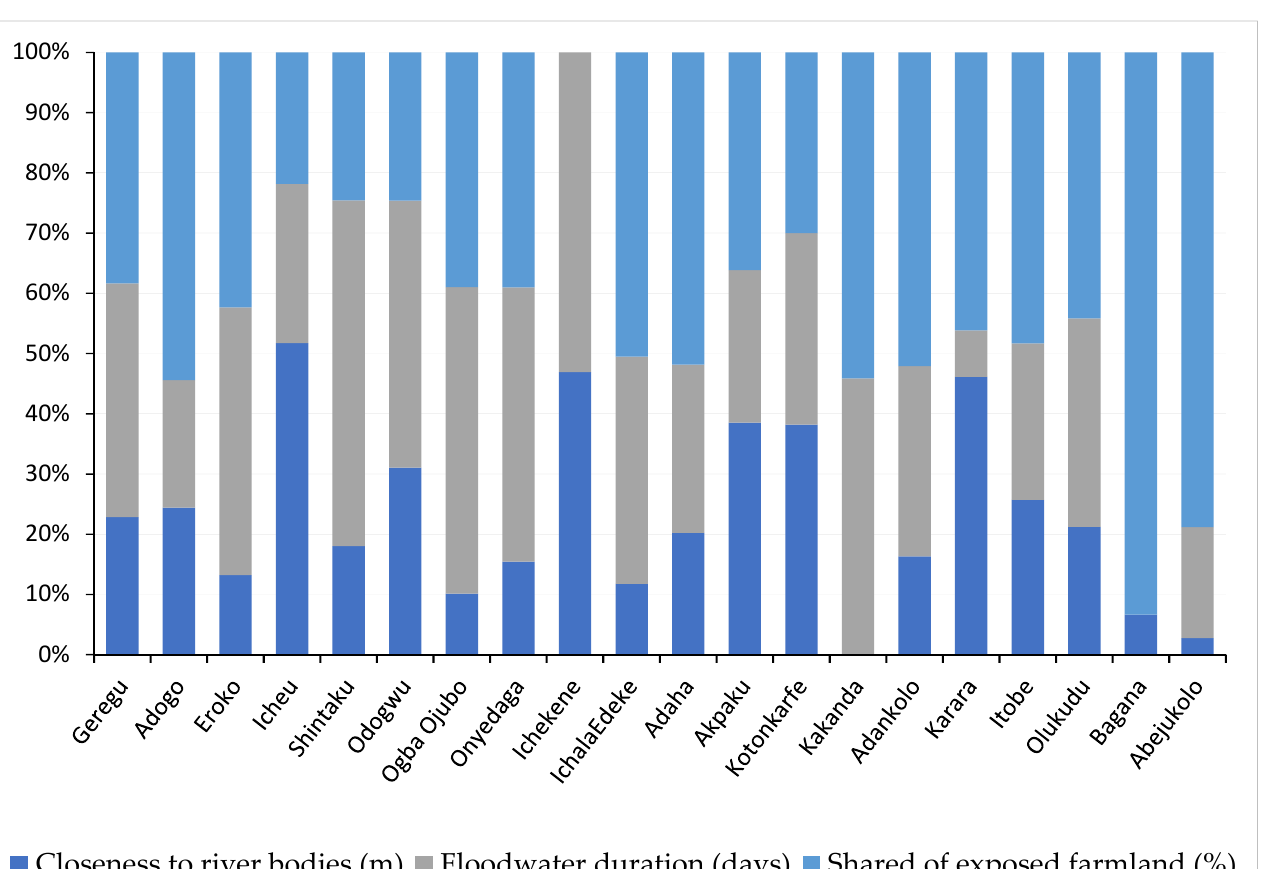
Figure 6. Contribution of the single indicator to the sub-index exposure ( SIE ) for the different selected flood-prone communities in Kogi State.